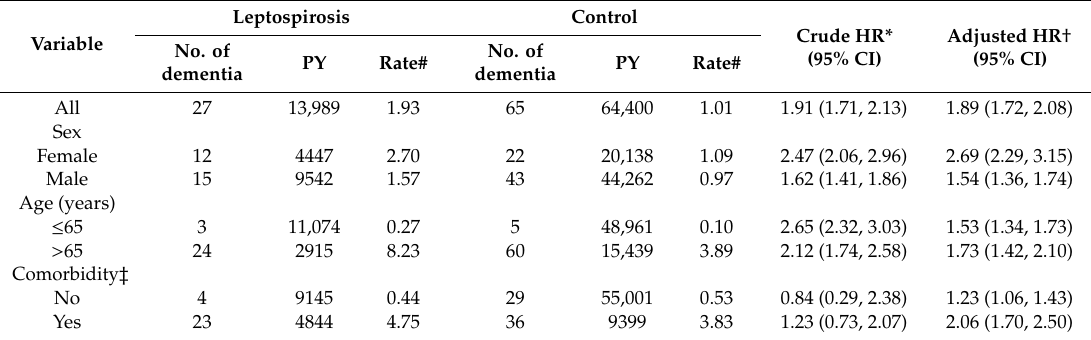
Table 2. Comparison of incidence and hazard ratios of dementia stratified by sex, age, and comorbidity between the leptospirosis and non-leptospirosis